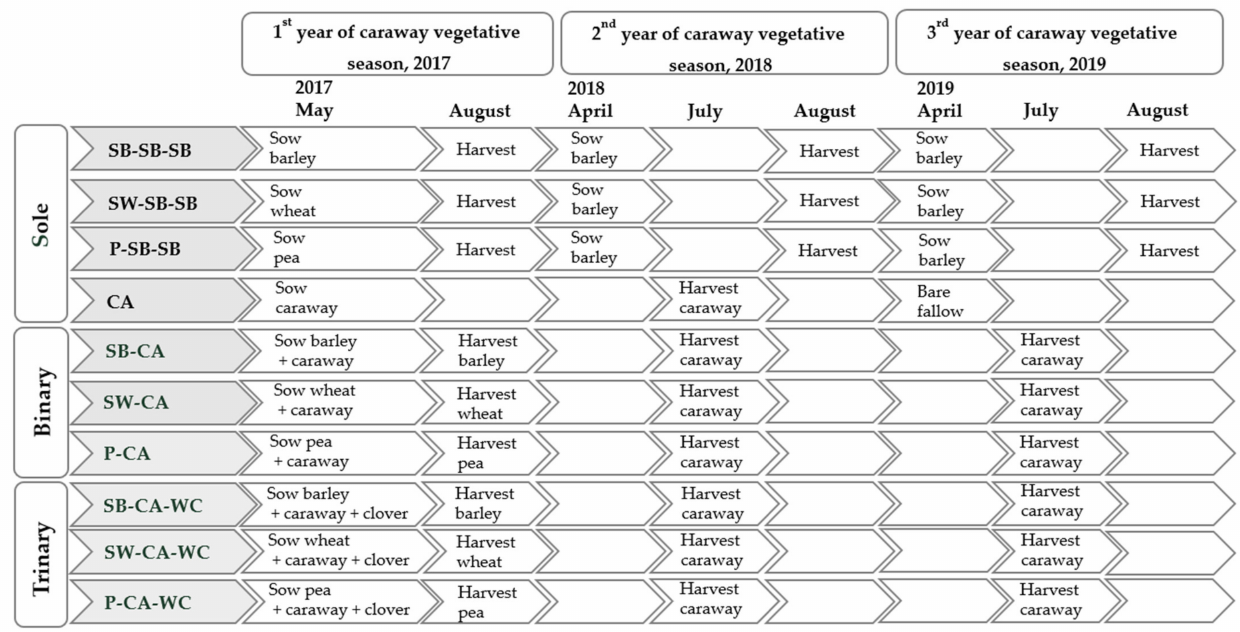
Figure 7. Timeline of the experiment. Note. CA—caraway; SB—spring barley; SW—spring wheat; P—pea; WC—white clover; BF—black fallow.